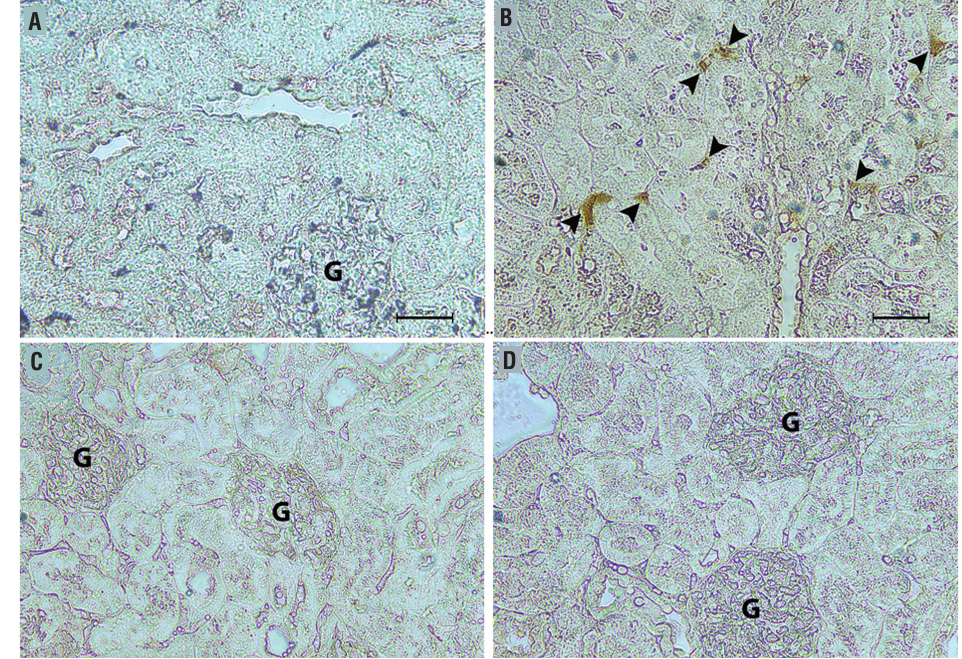
Figure 2 (A-D) - Representative photo micrographs of Mac387 immuno histochemistry of the renal cortex in the sham group (a) and sepsis group (b) 5mg/kg (c) and 10mg/kg tadalafil+sepsis groups (d).(a) and sepsis group (b) 5mg/kg (c) and 10mg/ kg tadalafil+sepsis groups (d). Arrows indicate areas of inflammatory cell infiltration.